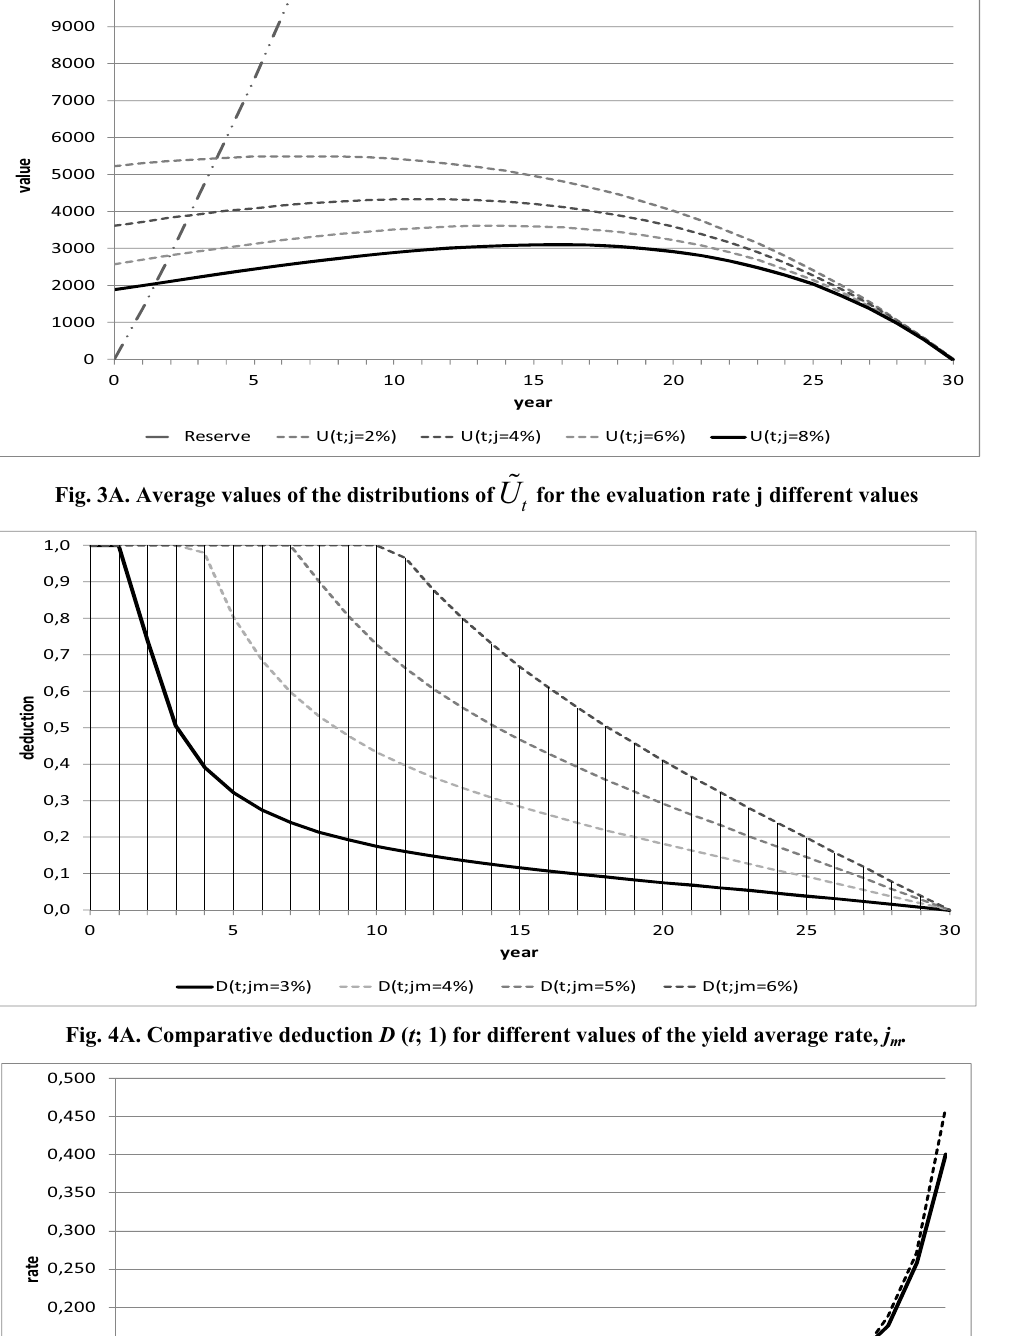
Fig. 5A. Skewness coefficients of the distributions of